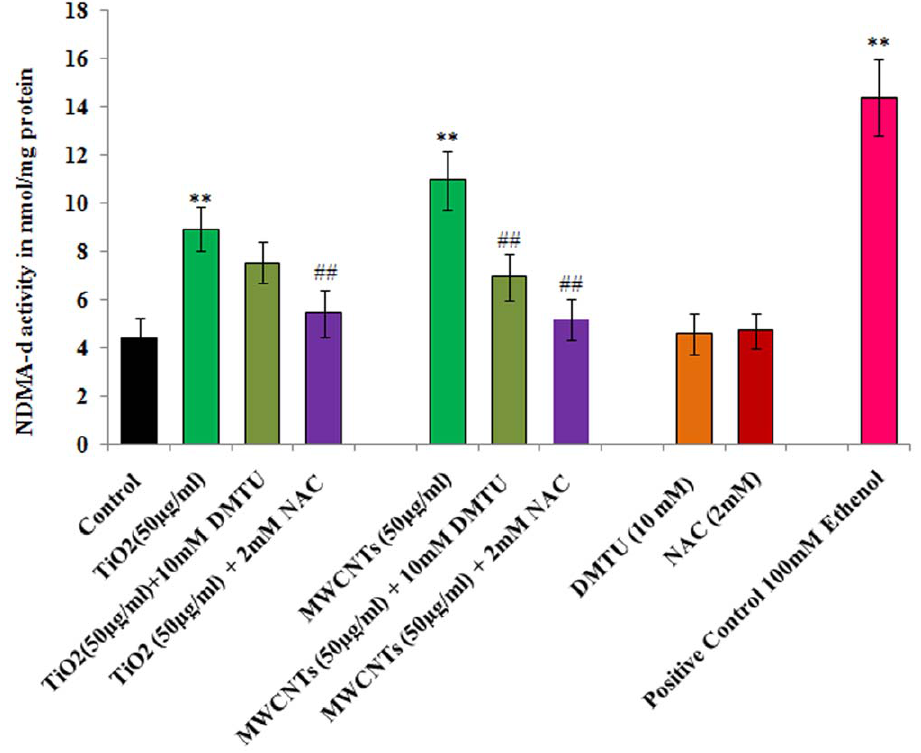
Figure 7. TiO 2 -NPs and MWCNTs (50 m g/ml) induced CYP2E1 dependent n- nitrosodimethylamine-demethylase (NDMA-d) activity in absences or presence of DMTU (10 mM)/ NAC (2 mM). All values are mean 6 S.E. of 3 experiments. ** P , 0.01 (unexposed control Vs TiO 2 - NPs/ MWCNTs exposure). ## P , 0.01 (TiO 2 -NPs/ MWCNTs exposure Vs DMTU/NAC treatment). Specific activity is expressed in nmol HCHO/min/mg protein. Ethanol (100 mM), a known inducer of CYP2E1, was used as positive